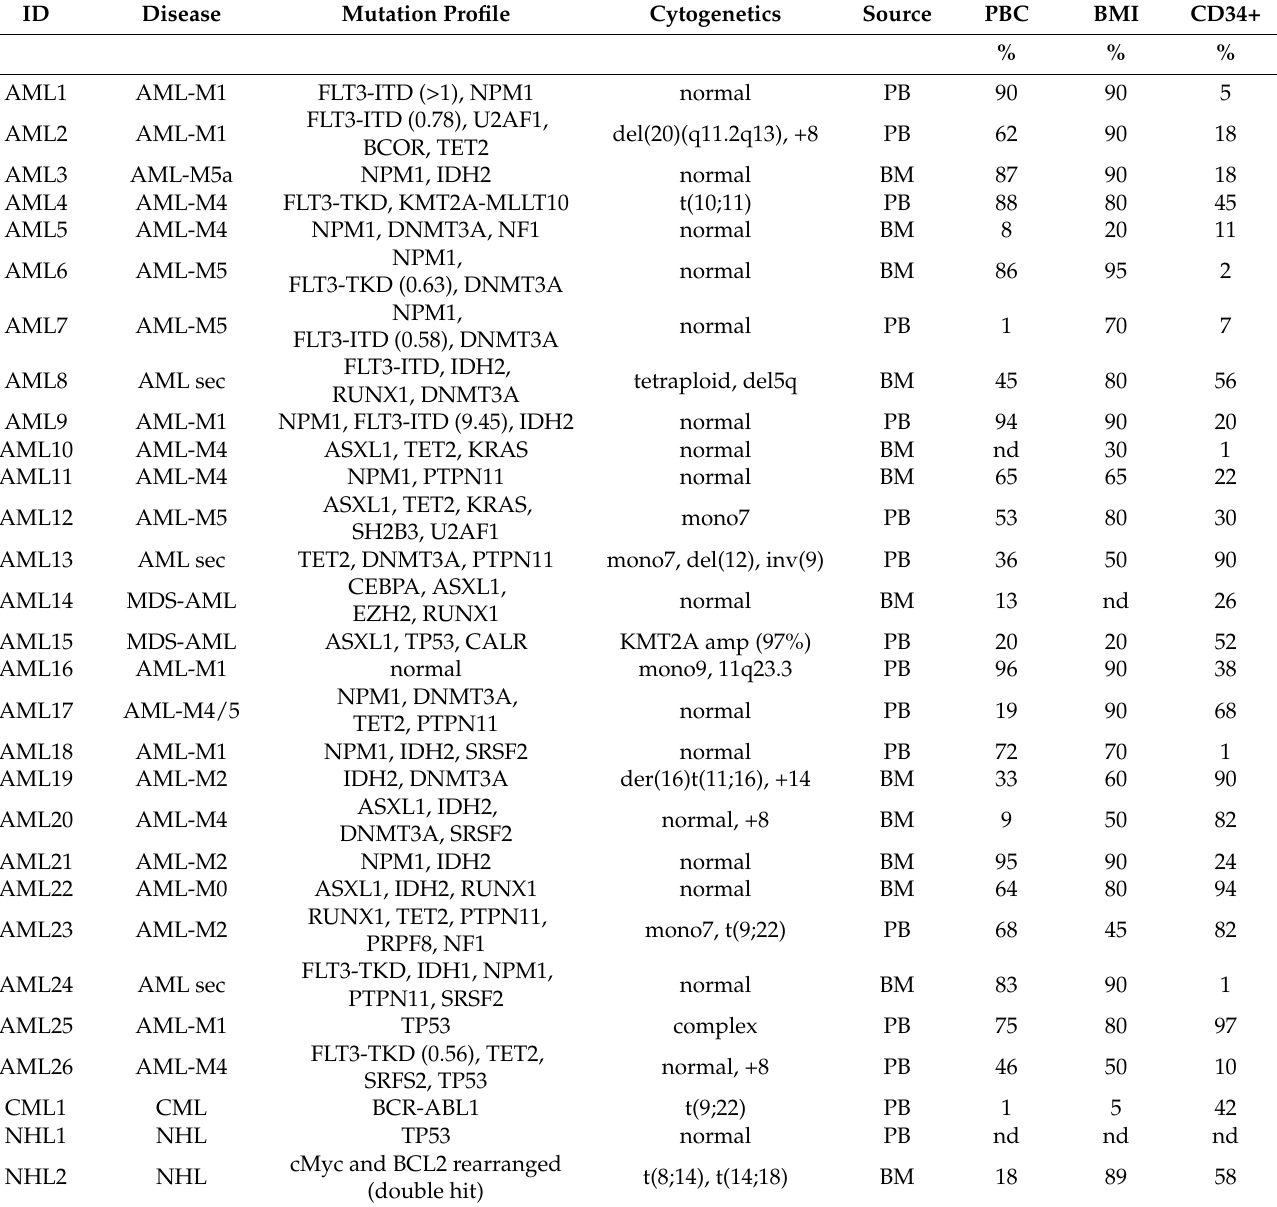
Table 4. Clinical characteristics of hematological